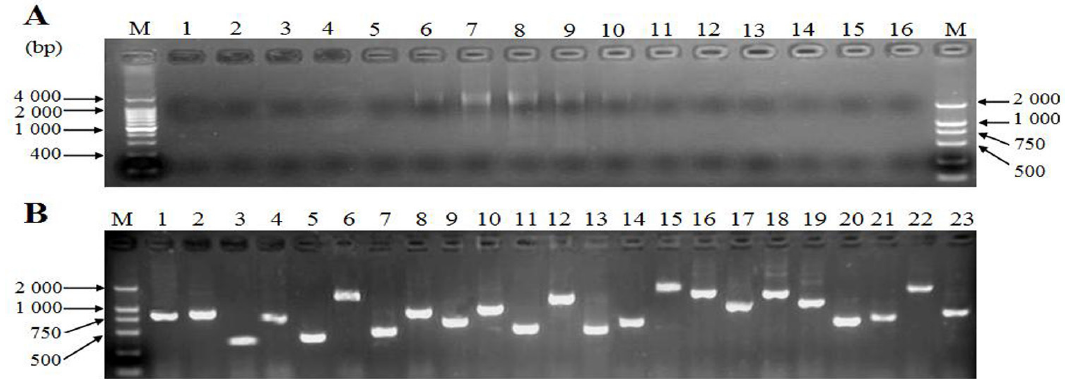
Figure 3. cDNA size fractionation and Recombinant clones screening. ( A ) cDNA size fractionation by CHROMA SPIN-400. M: DNA marker; 1–16: tube serial number; ( B ) Recombinant clones screening within the library. M: DNA marker; 1–23: PCR products for clones selected